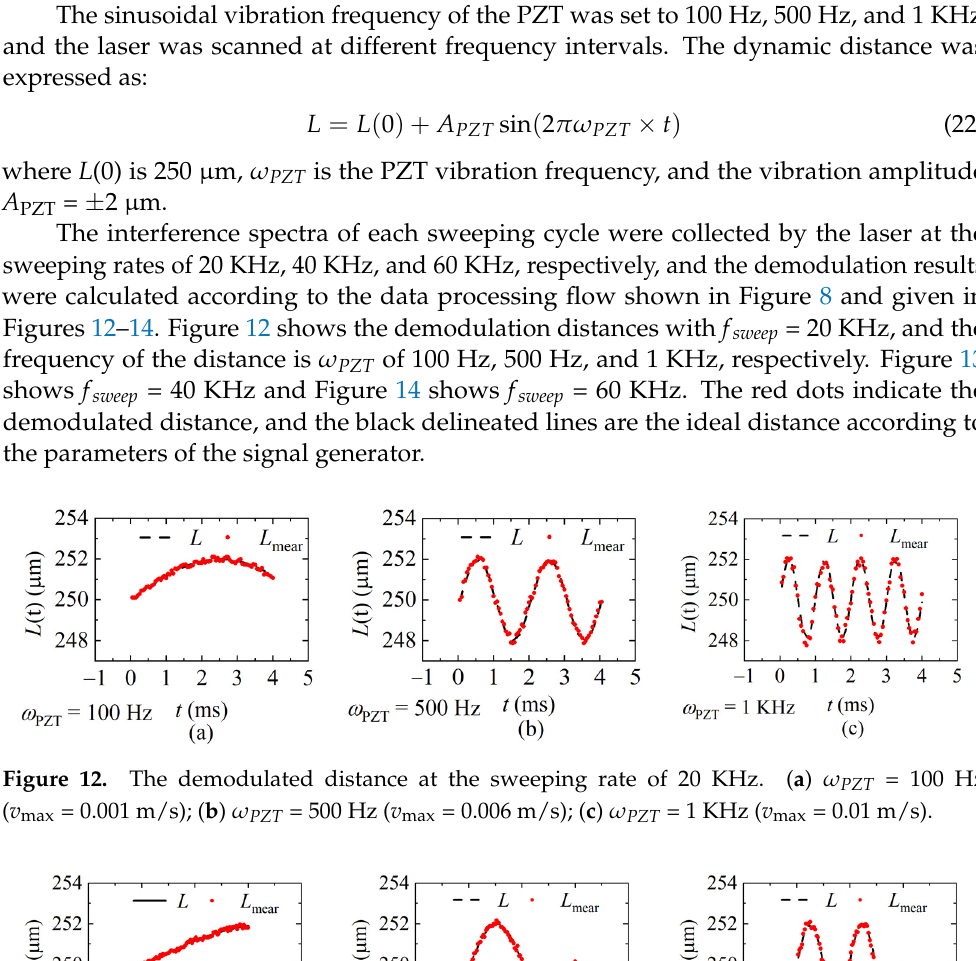
Figure 11. Experimental system diagram.